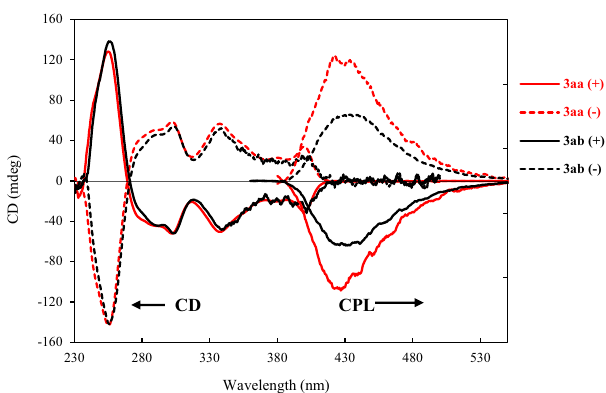
Fig. 4 CD and CPL spectra of aza-oxa-dehydro[7]helicenes (3aa and 3ab). Chiroptical properties of 3aa and 3ab (CD and CPL) were studied in CHCl 3 (2 × 10 − 5 M). 3aa showed high CPL activity with g lum = 2.5 × 10 − 3 at